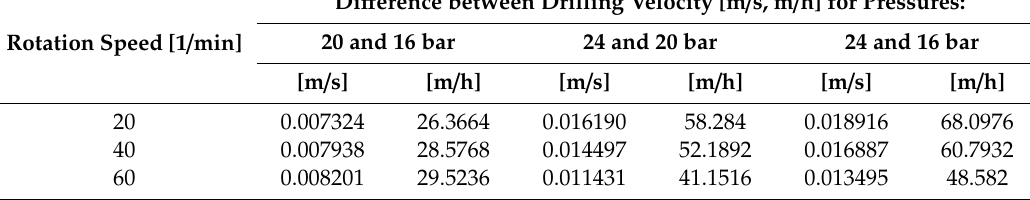
Table 3. Di ff erences between drilling velocity measured for various air pressures and drill rotation speeds of the 110 mm diameter drill bit, in the interval 90–108 m below ground